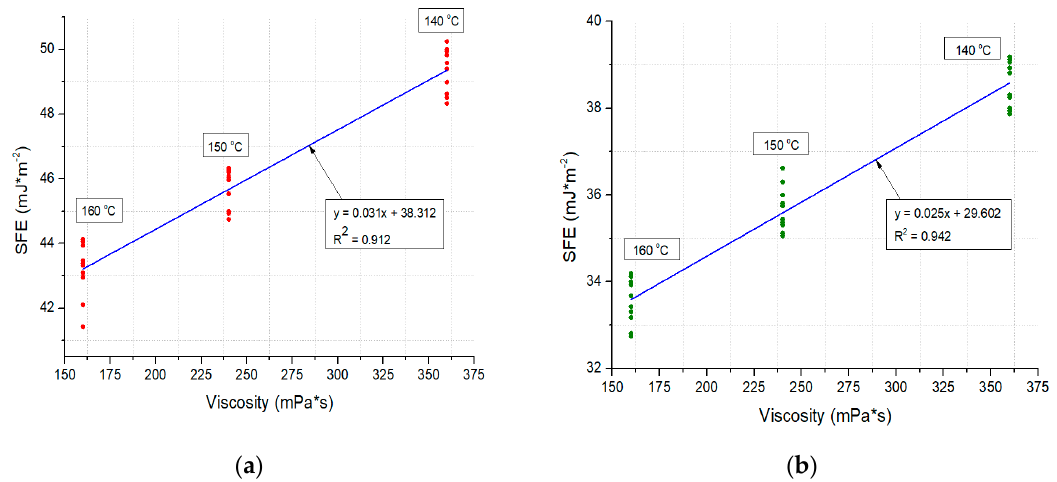
Figure 8. Correlations between viscosity and surface free energy values in mineral–asphalt mixtures: ( a ) WC-1; ( b ) WC-2.